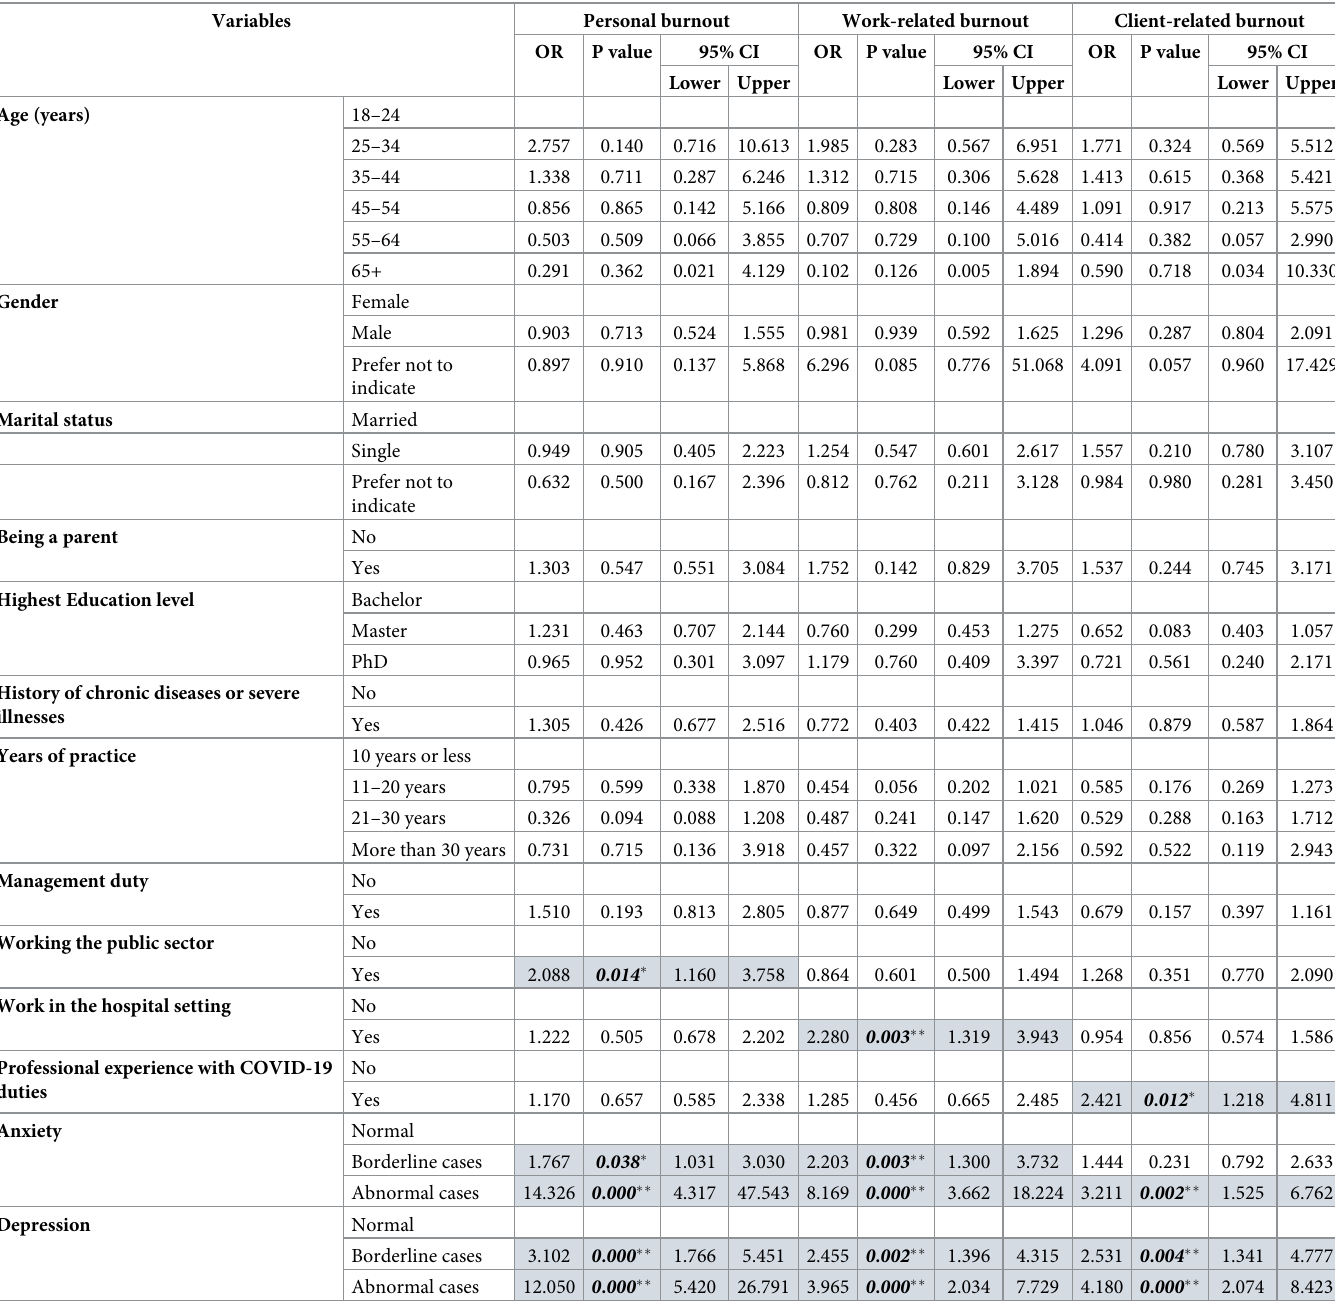
Table 5. Logistic regression analysis of factors associated with moderate to severe